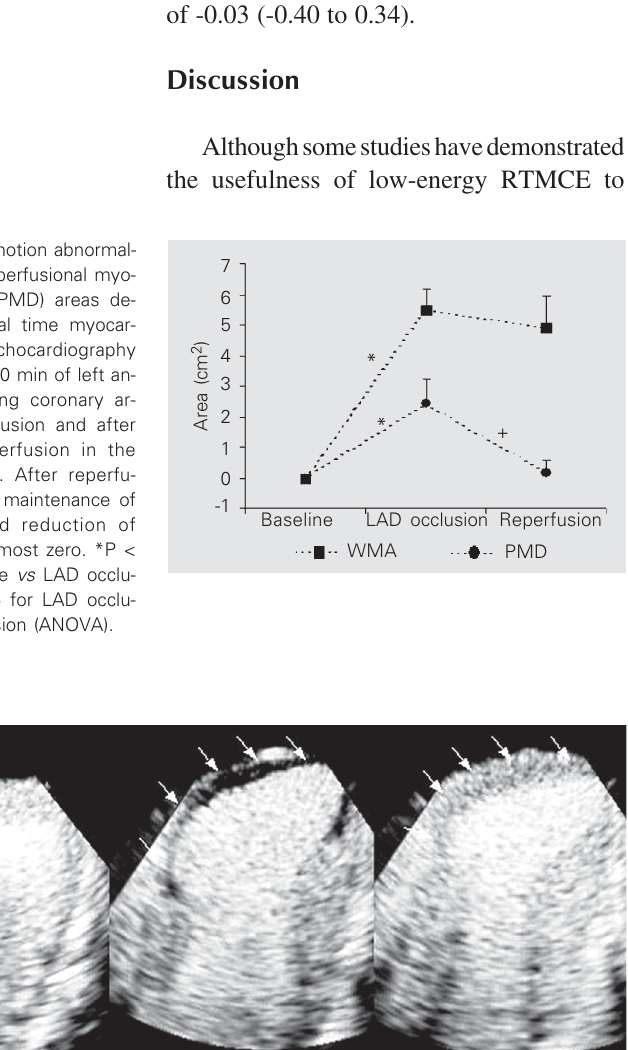
Figure 6. Representative example of real time myocardial contrast echocardiography in the stunned model showing normal myocardial perfusion at baseline (left) and risk area during left anterior descending coronary artery occlusion (arrows) in the center. After reperfusion (right) there was complete normalization of myocardial perfusion with maintenance of wall motion abnormality (arrows), demonstrating